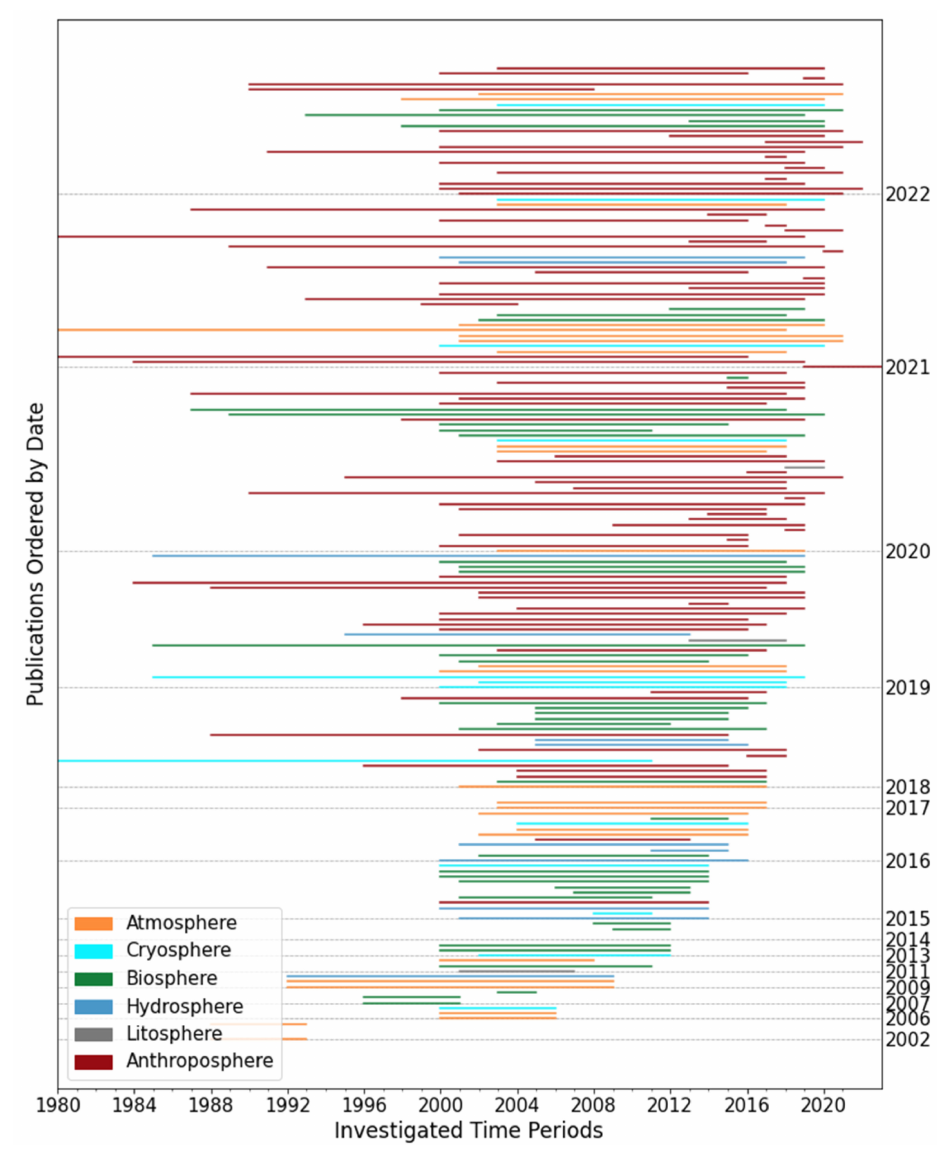
Figure 11. Investigated study periods ( x -axis) for every reviewed study employing a time series. The y -axis visualizes the year of publication. The colors represent the research spheres covered by the studies. Studies covering topics from multiple research spheres are displayed several